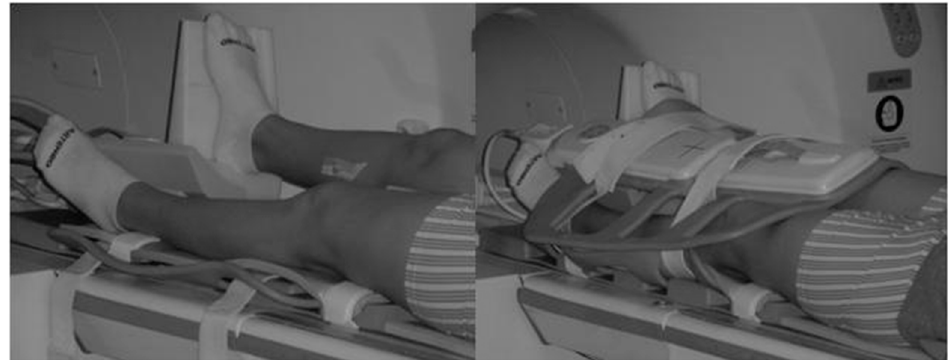
Figure 1. ( Left ) Subject in the supine position with the leg in the custom-made structure, which avoided compression of the leg muscles against the MRI table. ( Right ) The leg with the pelvic coil. Leg immobilization was carried out by using a custom-made structure, which was made of a nonmagnetic material, adjustable to the subject’s leg length and avoided